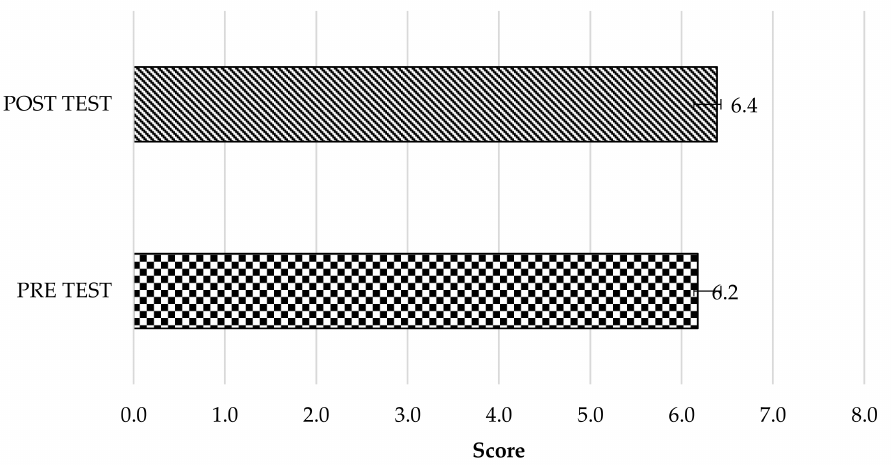
Figure 3. Pre- and post-test average score (n =